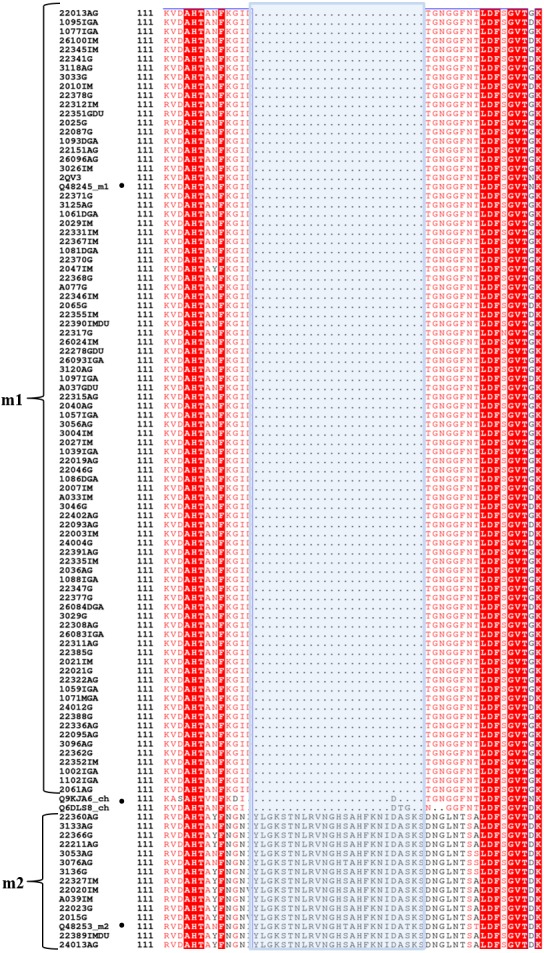
Protein sequence alignment of p55 VacA from H. pylori of Colombian mestizos.The strain names are given to the left. The middle section of VacA (shaded with light blue) differentiates the m1 and m2 types, respectively. The m1 sequence types, characterized by its lack of the middle section (top sequences), were the most prevalent in the studied population in comparison to the m2 sequence type, which has a clear middle section (bottom sequences). Amino acids marked with red correspond to strictly conserved residues between all aligned sequences. Black dots mark the chosen reference VacA sequences for m1, m2 and chimera (ch) alleles (Atherton et al., 1999; Cover et al., 1994). The alignment was performed using Muscle software and displayed in ESPript server.